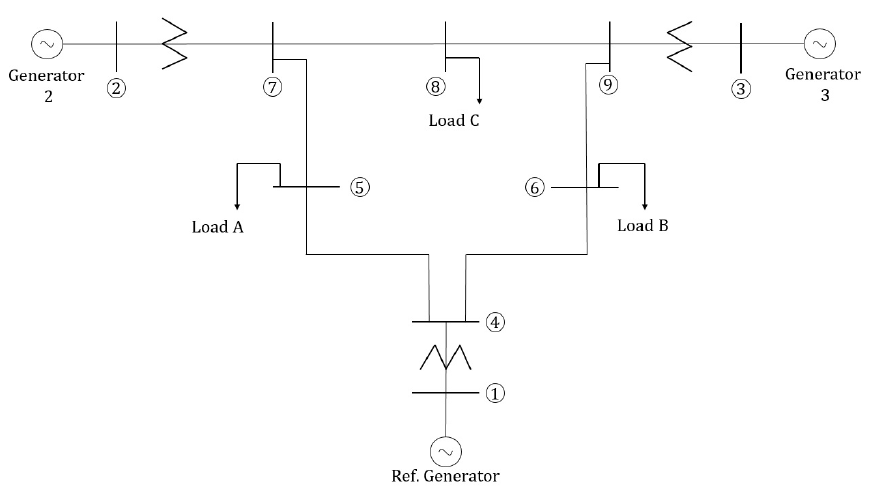
Figure 4. Nine-bus testing system.